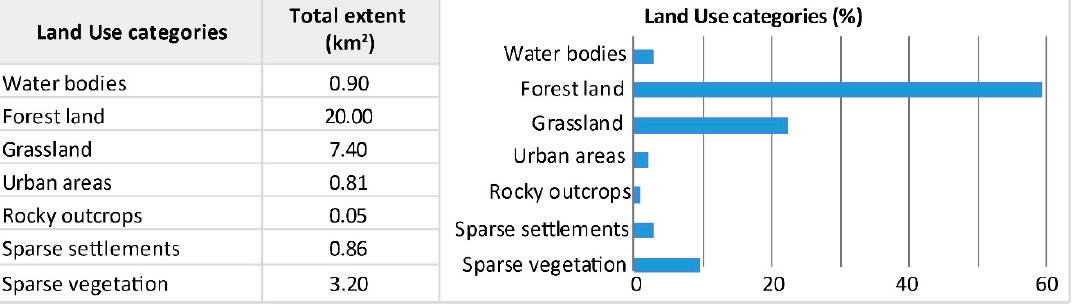
Figure 6. Categories of land use as respect the total extent of the AOIs.